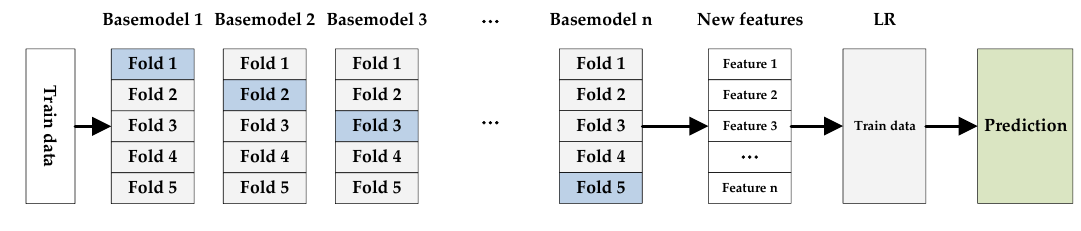
Figure 5. Model stacking.